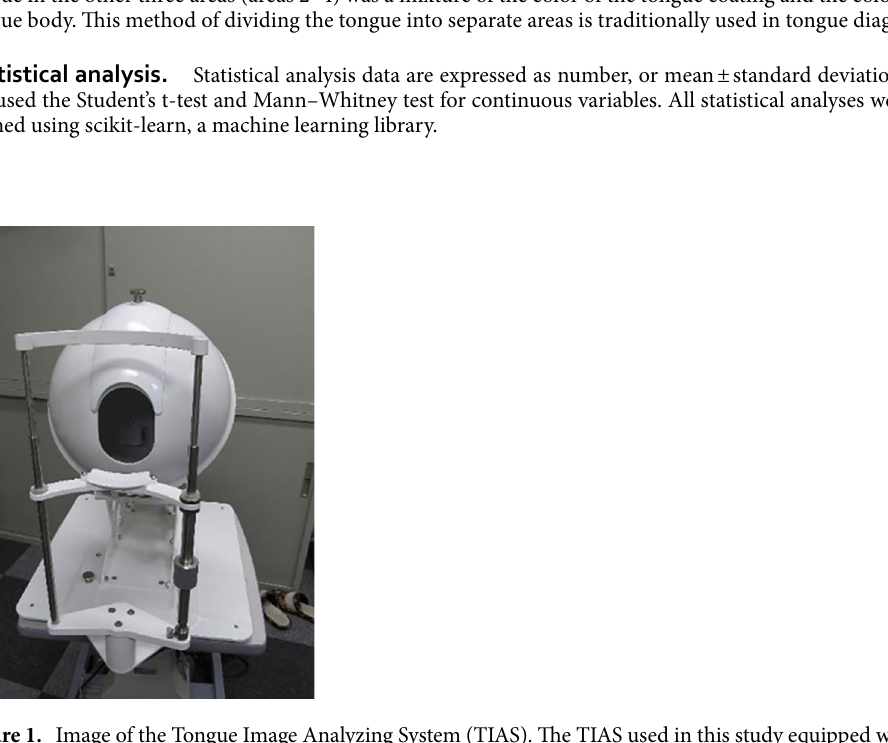
Figure 1. Image of the Tongue Image Analyzing System (TIAS). The TIAS used in this study equipped with a chin rest and a forehead rest for fixing the face of the